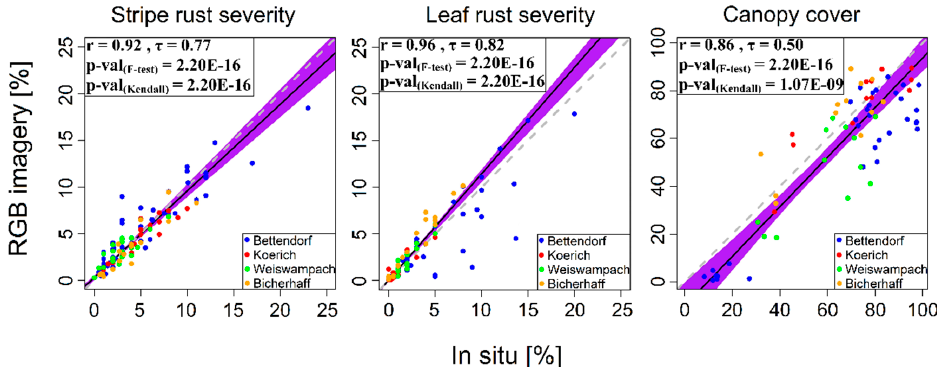
Figure 7. Scatterplots of Red-Green-Blue (RGB) imagery-derived estimates and observed values of wheat stripe rust severity ( left ), wheat leaf rust severity ( middle ), and canopy cover ( right ). Data from the four dates of image acquisition were pooled. The black and dashed-grey lines indicate the deming regression fit and 1:1 lines, respectively. The purple area is the 95% confidence interval of the deming regression fit. (Note the differences in scale for the canopy cover).